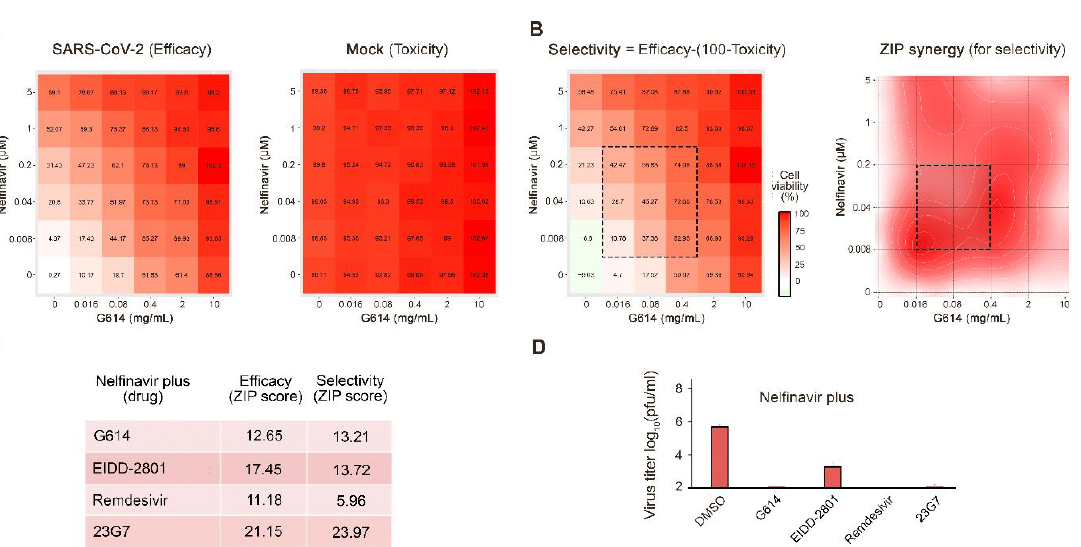
Figure 2. Combinations of nelfinavir with convalescent serum, neutralizing antibody, EIDD-2801, or remdesivir rescue Calu-3 cells from severe acute respiratory syndrome coronavirus 2 (SARS-CoV-2)-mediated death and inhibit virus replication. ( A ) The interaction landscapes of one of the combinations measured using a CTG assay on SARS-CoV-2- and mock-infected cells. ( B ) The interaction landscape showing selectivity and synergy of the drug combination. ( C ) Synergy scores were calculated for e ffi cacy (SARS-CoV-2-infected) and selectivity (SARS-CoV-2-infected–Mock-infected) dose-response matrices for drug combinations. ( D ) The e ff ects of 1 µ M nelfinavir plus 0.1% DMSO, 2 mg / mL G614, 1 µ M EIDD-2801, 1 µ M remdesivir or 2 ng / mL 23G7 antibody on viral replication measured by plaque reduction assay.